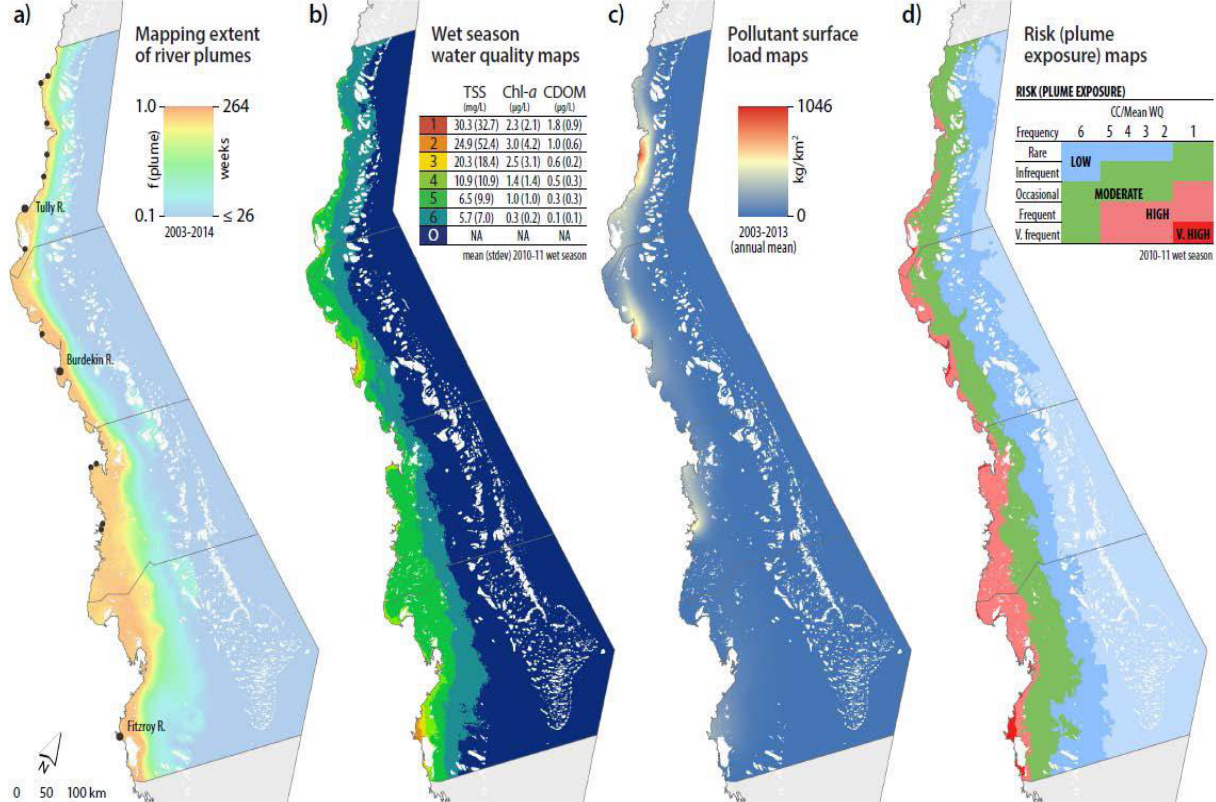
Figure 6. Outputs, expressed as GBR spatial maps, from the analysis and processing of true colour (Level-1) data extracted across the GBR. Maps include: ( a ) the extent and frequency of river plume in the GBR, reported as a multi-seasonal value for the period 2003–2013. The frequency value is calculated as the number of weeks within the wet season (December–April, ca . 22 weeks) over the 10-year period in which the pixel was exposed to river plume waters. River plume was identified by the extraction of colour class categories (CC1–CC6); ( b ) wet season water quality maps showing the mean colour class associated with each pixel for the wet season period December 2010–April 2011. Each colour class category is described by mean water quality values for TSS, CDOM, chlorophyll-a, and Kd (PAR); ( c ) surface load maps (or concentration maps) of Dissolved Inorganic Nitrogen (DIN) representing the mean surface concentration of DIN (reported as µM) per 500 m × 500 m pixel for the wet season period December 2010–April 2011; and ( d ) spatial risk maps showing the qualitative categories of risk associated with different permutations of plume frequency (as a proxy for intensity of impact) and the mean colour class value (as a proxy for the water quality concentration gradient). (b) Wet Season Water Quality Maps (Table 2; VII) Wet season water quality maps are defined as maps where water quality concentrations associated with the level of land-sourced contaminants are measured or predicted, and are produced by